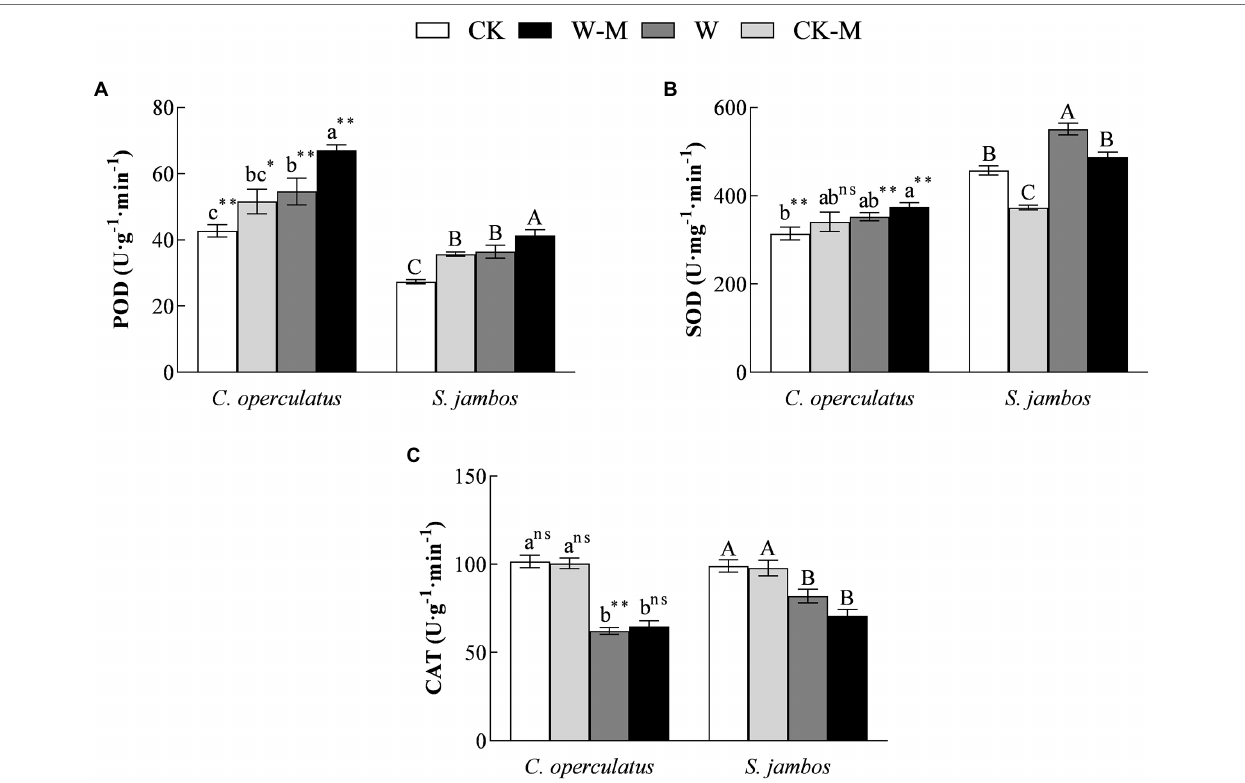
FIGURE 5 | The variations of POD (peroxidase, A ), SOD (superoxide dismutase, B ), and CAT (catalase, C ) in C. operculatus and S. jambos among different treatments. Values are means ± SE ( n = 6). Different little and capital letters indicate significant differences among different treatments within the same species according to ANOVA’s test ( p < 0.05). CK, pure planting pattern under well-watered condition; CK-M, mixed planting pattern under well-watered condition; W, pure planting pattern under waterlogging condition, W-M; mixed planting pattern under waterlogging condition. The signs such as * , ** , and ns concern the significance difference between the two species under the same treatment. * p < 0.05; ** p < 0.01; ns,